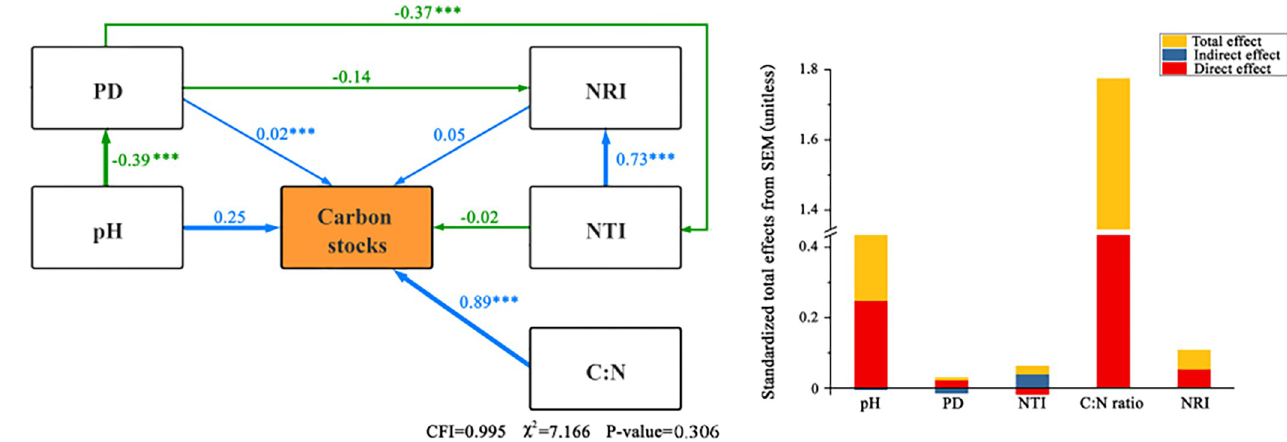
Fig 5. Structural equation model of the relationship between plant diversity and abiotic factors and carbon stocks.